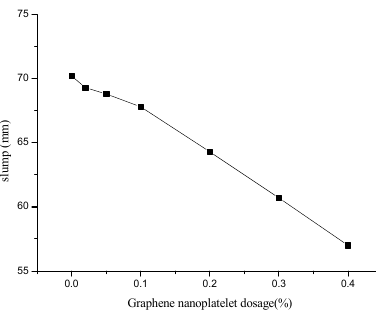
Figure 5. The slump of concrete.